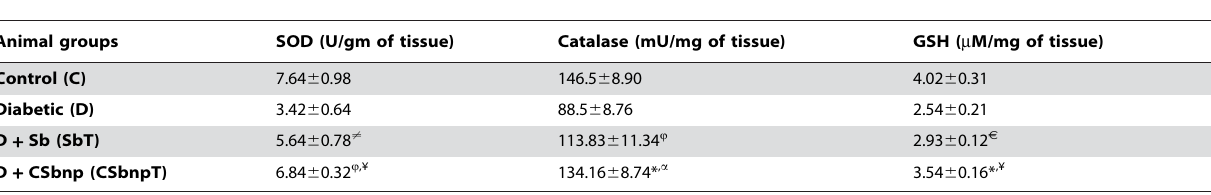
Table 3. Effect of Sb and CSbnp over antioxidant status of liver in diabetic rats.